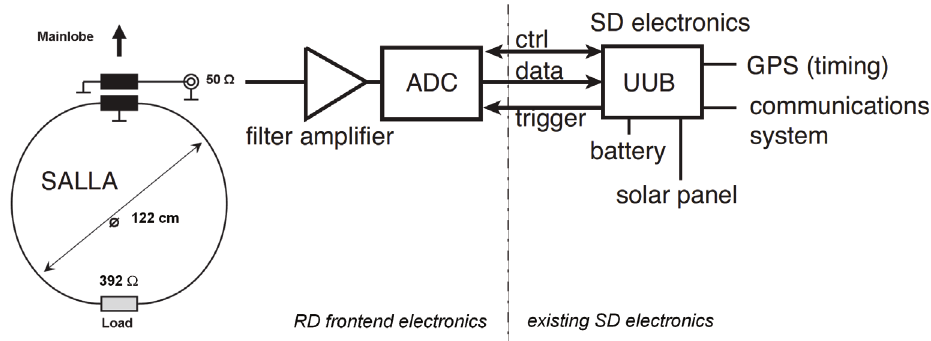
Figure 2. Schematic diagram for the RD readout chain and its connection to the existing Surface Detector electronics via the Upgraded Unified Board (UUB). Updated from [5].